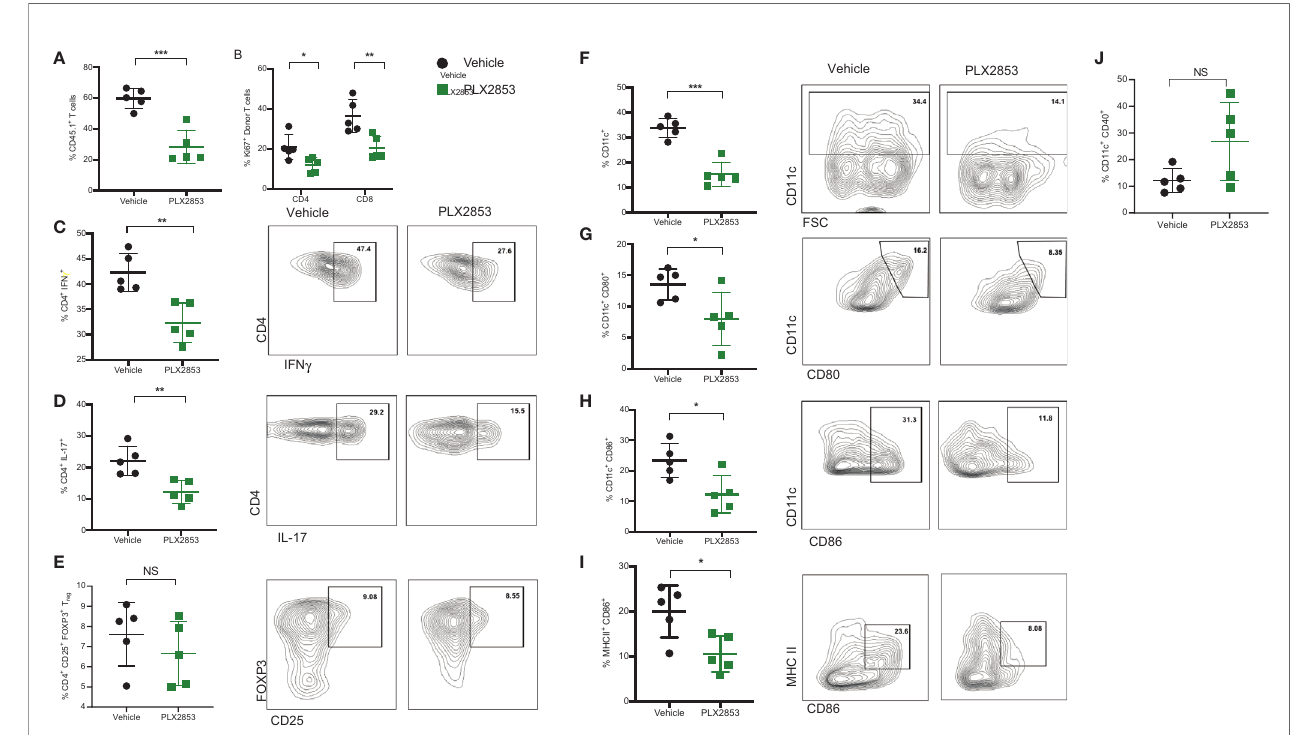
FIGURE 3 | BET inhibitor PLX2853 reduces T cell and DC in fl ammatory responses in vivo . B6D2F1 recipients were lethally irradiated and received TCD-BM and splenocytes from CD45.1 B6 mice. Recipients were treated with vehicle or PLX2853 as described in methods. On days 25-28 post-transplant, cohorts of mice (n=5 each) were euthanized and splenocytes were harvested for ex vivo fl ow cytometry experiments. Percentage of (A) CD45.1 donor T cell in spleens, (B) Ki67+ donor T cells. (C – E) Splenocytes were stimulated with PMA/ionomycin plus protein transport inhibitors to stimulate cytokine secretion. Percentages of donor CD4+ IFN g +, CD4+ IL-17+, and Treg populations are shown. Percentages of (F) CD11c+ DC, (G) CD80+, (H) CD86+, (I) CD86+ MHC II+ DCs and (J) CD40+ DCs. Data shown is representative of one of two independent transplant experiments. *p < 0.05, **p < 0.01, ***p < 0.001. NS, not signi fi